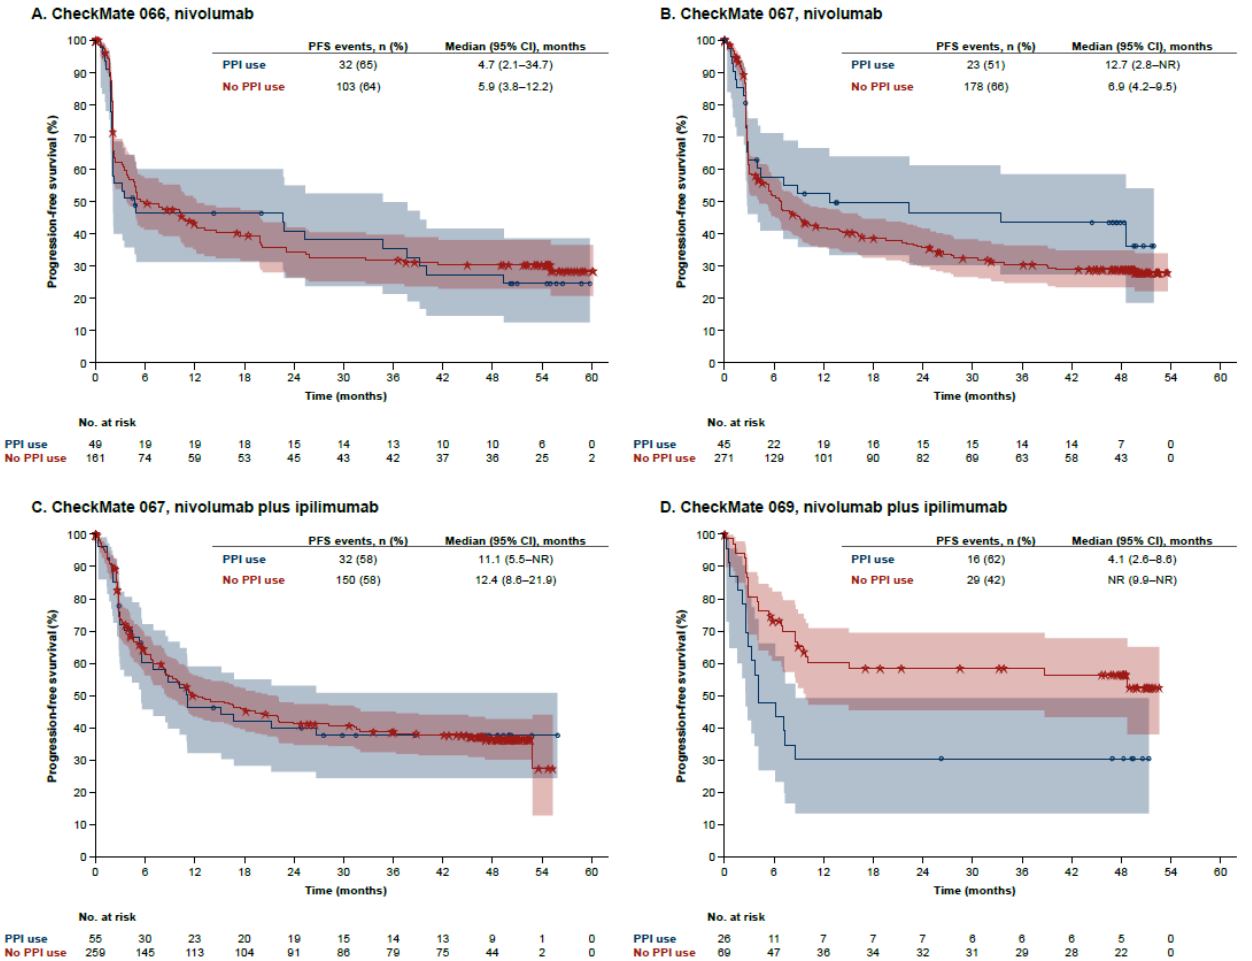
Figure 2. Progression-free survival by baseline PPI use in the nivolumab-containing treatment arms of CheckMate 066, 067, and 069. Kaplan–Meier estimates of progression-free survival are shown in the nivolumab arms of CheckMate 066 ( A ) and CheckMate 067 ( B ) and in the nivolumab plus ipilimumab arms of CheckMate 067 ( C ) and CheckMate 069 ( D ). Shaded areas are 95% log–log confidence bands. CI: confidence interval; PFS: progression-free survival; PPI: proton pump inhibitor.